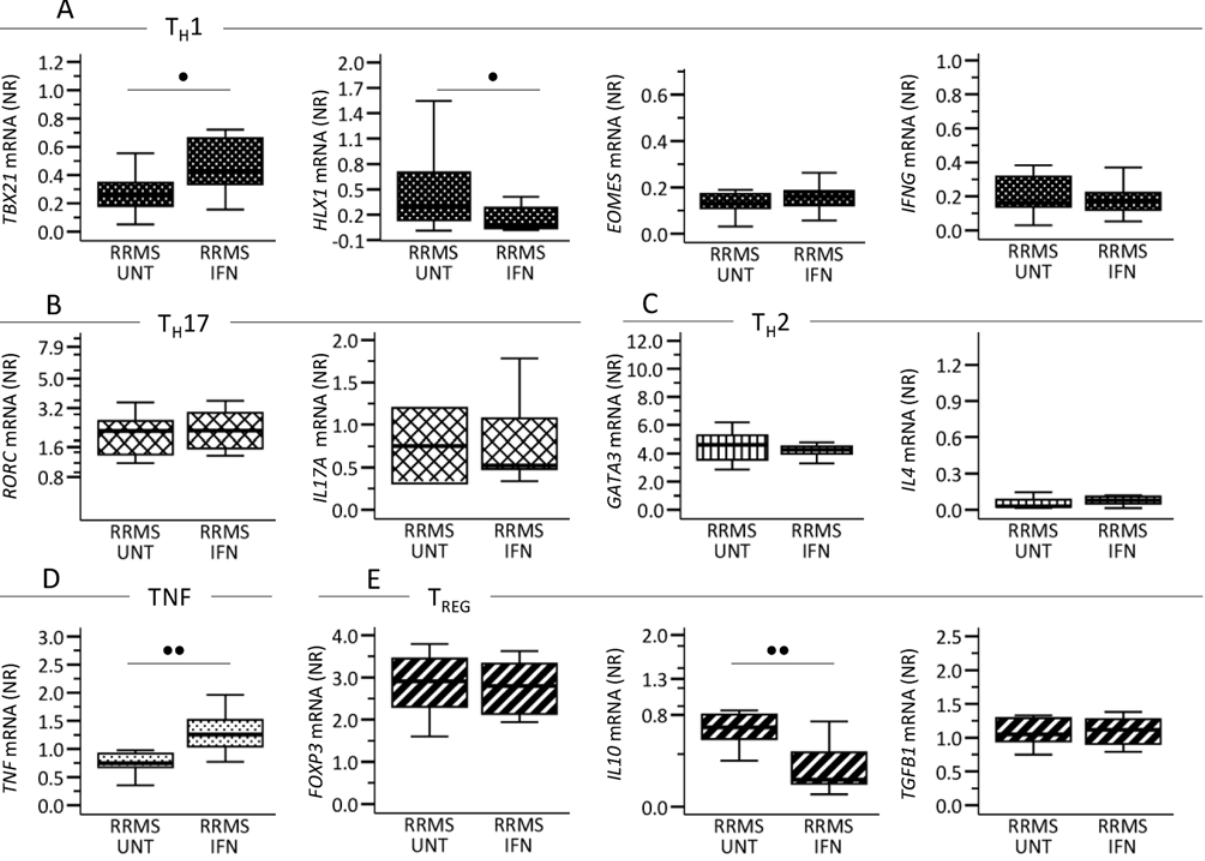
Fig 2. Circulating CD4 + T-cells ’ in vivo mRNA expression of (A) T-helper (T H ) 1, (B) T H 17, (C) T H 2, (D) TNF and (E) T-regulatory (T REG ) associated molecules in 11 untreated (UNT) and 12 interferon(IFN)- β treated patients with relapsing-remitting multiple sclerosis (RRMS). IFN- β treated patients were sampled 36 – 48 hours after injection of IFN- β . CD4 + T-cells were isolated by immunomagnetic labeling and separation. Gene expression levels are given as normalization ratio (NR), boxes represent interquartile range, median value indicated as a line; whiskers represent range. Studies were made on the sub-study 2 population. Statistics was by the Mann-Whitney U test. (cid:129) = p < 0.05, (cid:129)(cid:129) = p < 0.005.